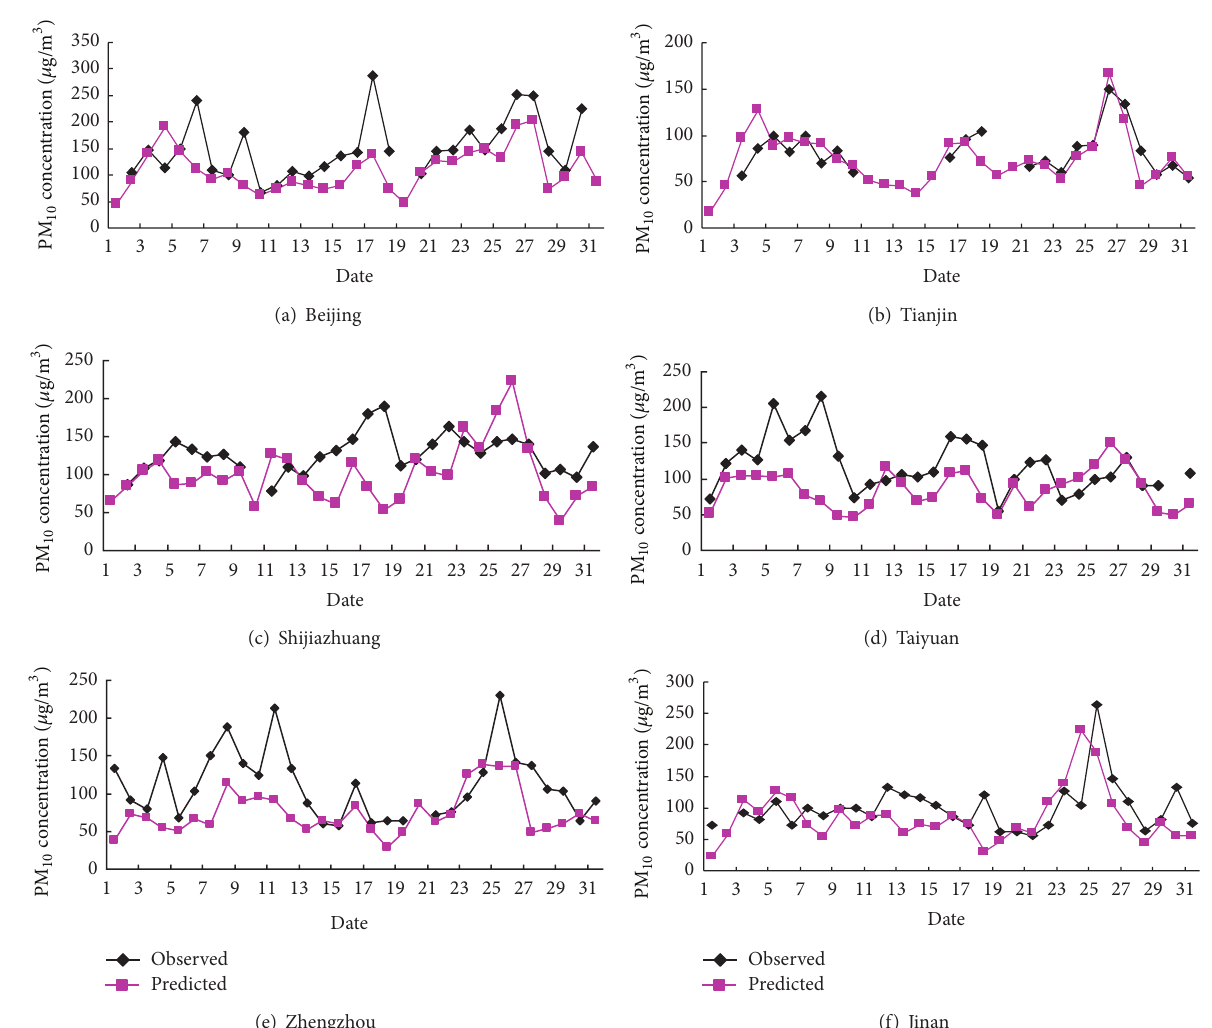
Figure 2: Comparison of observed and simulated daily average PM 10 concentration in July